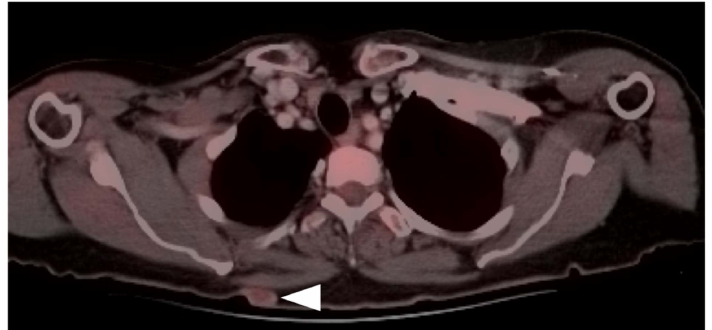
Figure 29. Cutaneous neurofibroma in a patient with neurofibromatosis type-1 (NIF-1). The nodule showed very mild metabolic activity (white arrowhead) similar to that of background muscle.